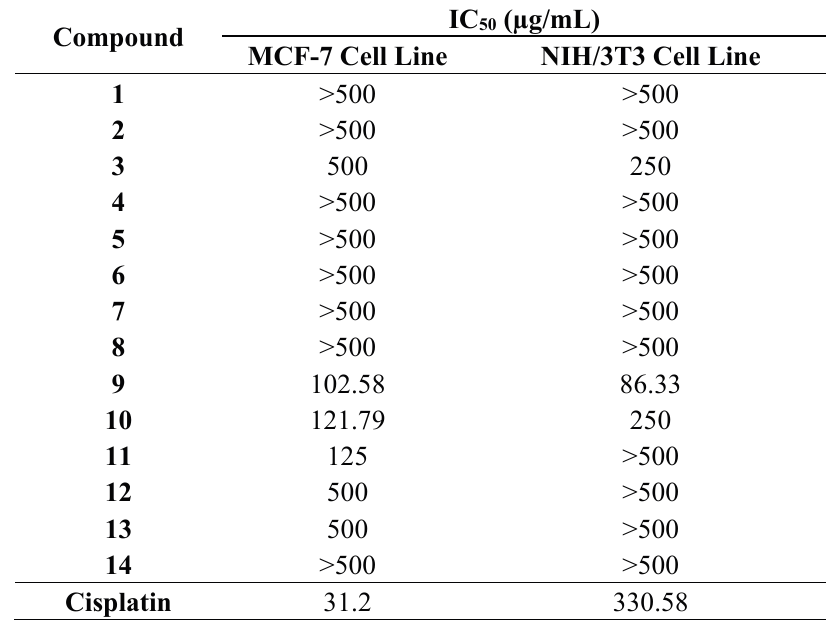
Table 3. The cytotoxic effects of the compounds 1 – 14 on the MCF-7 and NIH/3T3 cell